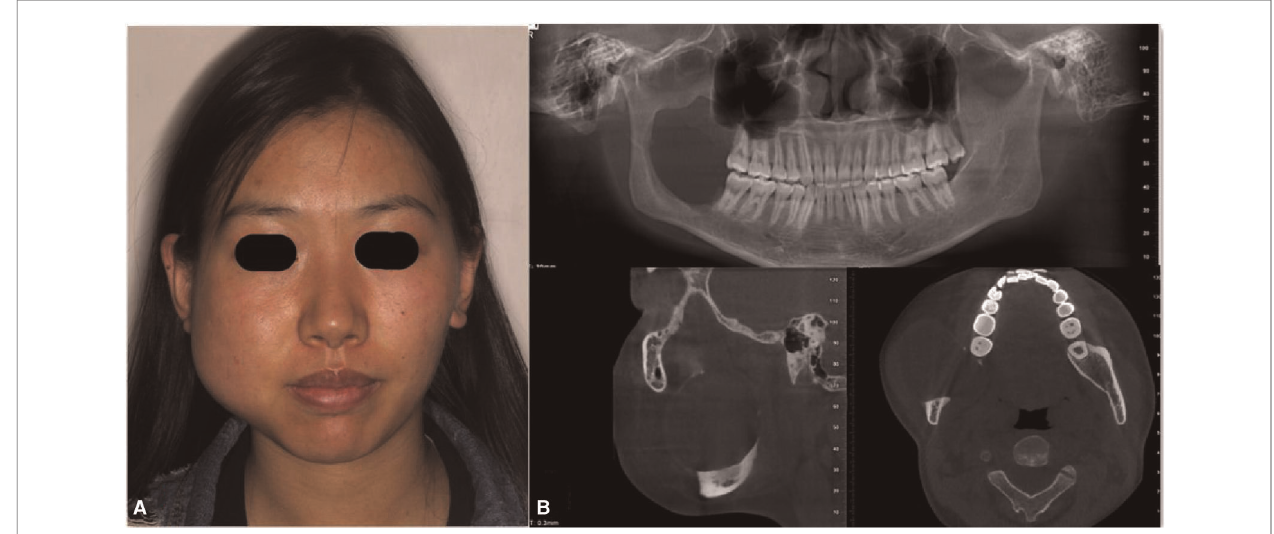
FIGURE 1 | Clinicalexaminationrevealingasigni fi cantbulgeoftherightmandibular:conebeamcomputerizedtomography(CBCT)demonstratingthat( A )therewasabone mineral density reducing area of nabout 4.8 cm×4.6 cm×4.9 cm in the right mandible from 47 to the mandibular ramus region and ( B ) Buccolingual bulge was obvious.